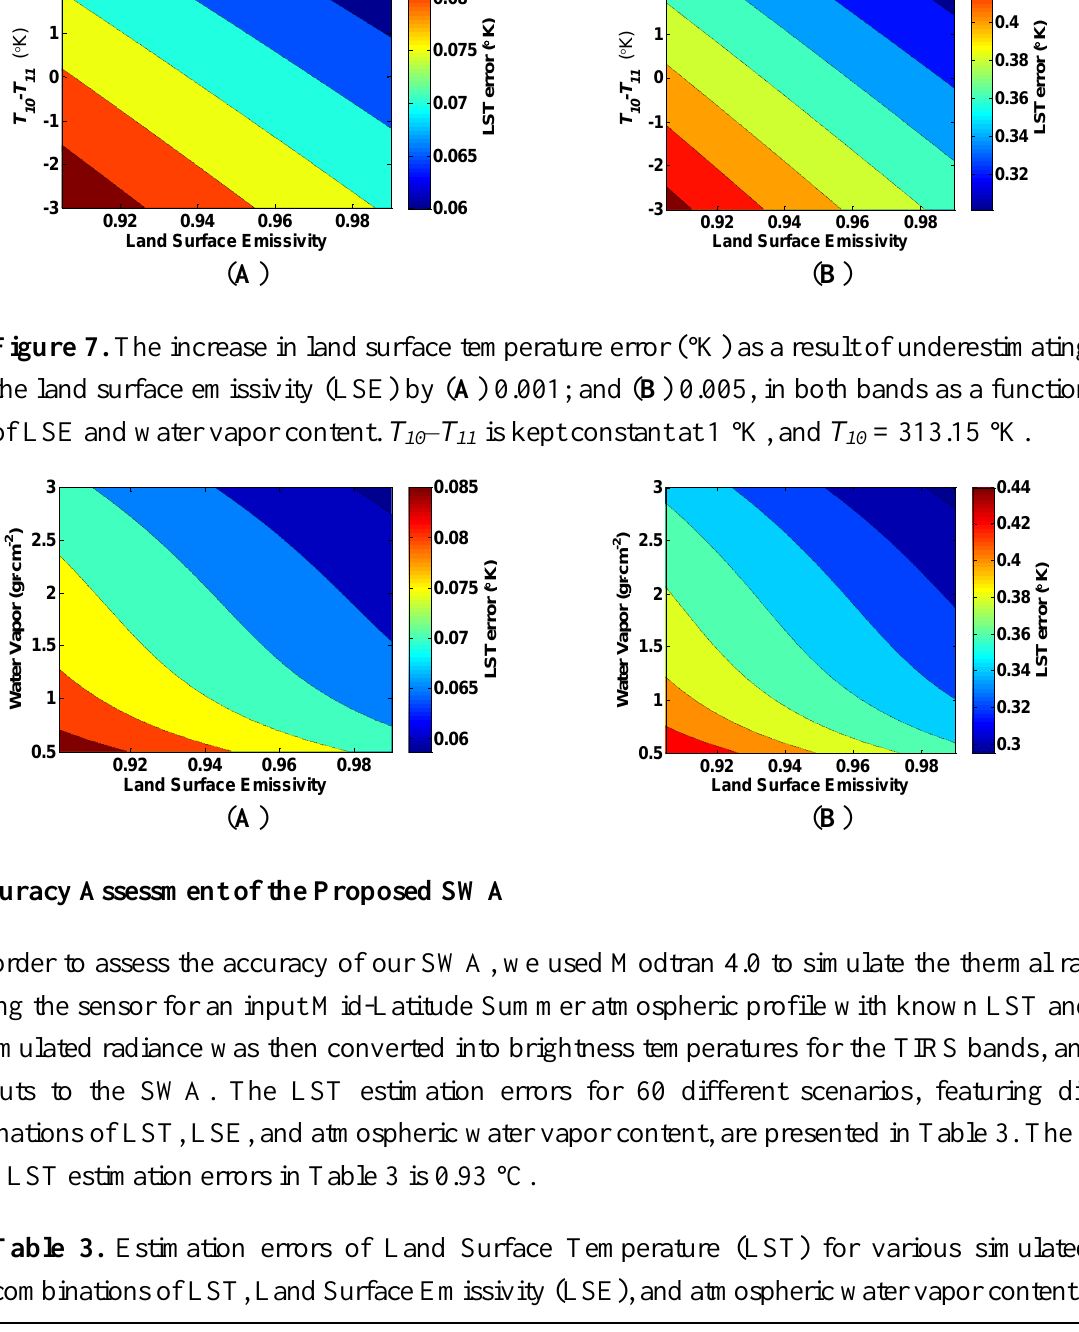
Figure 6. The increase in land surface temperature error (°K) as a result of underestimating the land surface emissivity (LSE) by ( A ) 0.001; and ( B ) 0.005, in both bands as a function of LSE and T – T . The water vapor content is assumed to be 1.5 g · cm −2 and T 10 11